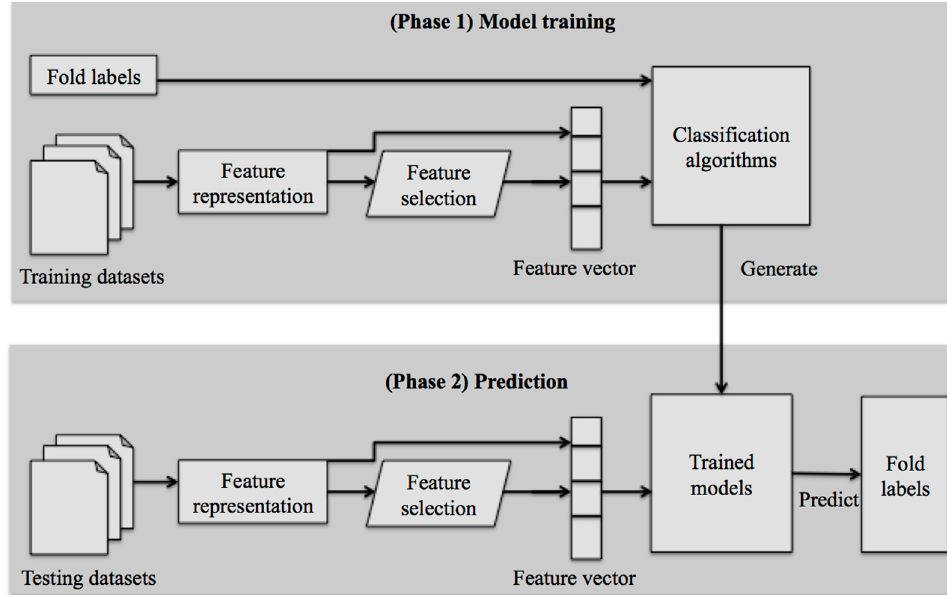
Figure 2. Framework of machine learning-based methods for protein fold recognition.